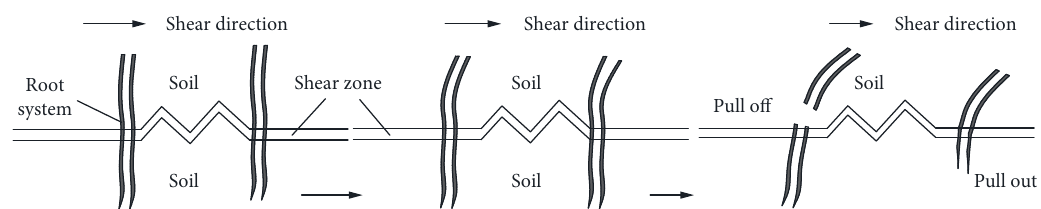
Figure 13: Schematic diagram of the mechanism of root-soil contact surface action and progressive damage